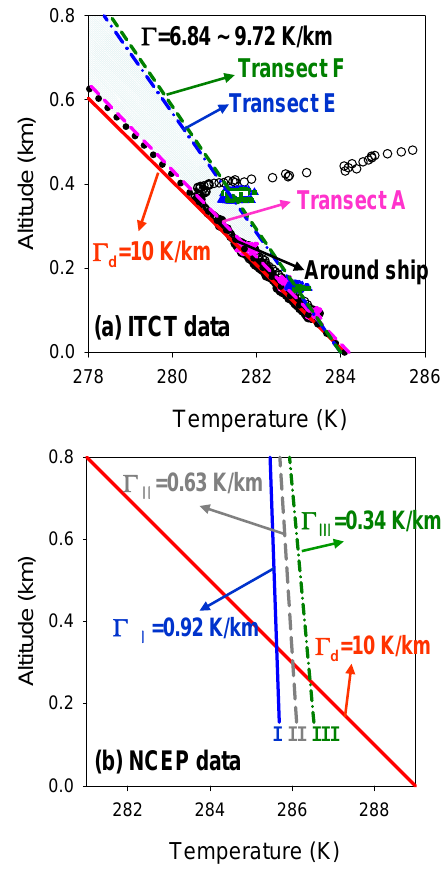
Fig. 3. Comparison between actual lapse rate ( 0 ) and dry adiabatic lapse rate ( 0 d ) for the determination of stability class of the MBL (a) with observations measured by NOAA WP-3D flight and (b) with NCEP 6 hourly reanalysis-2 pressure level